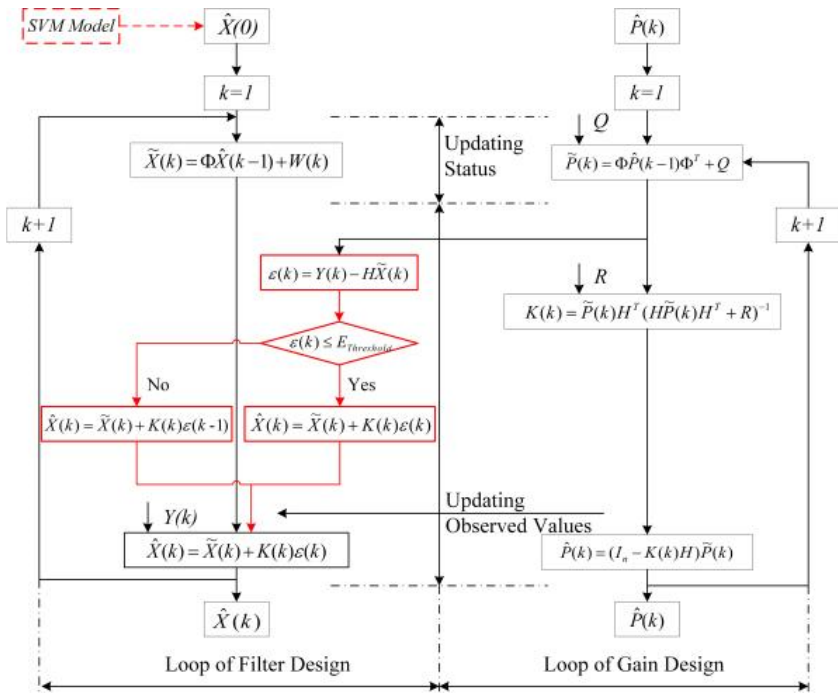
Figure 4. Flowchart for the improved Kalman filter.